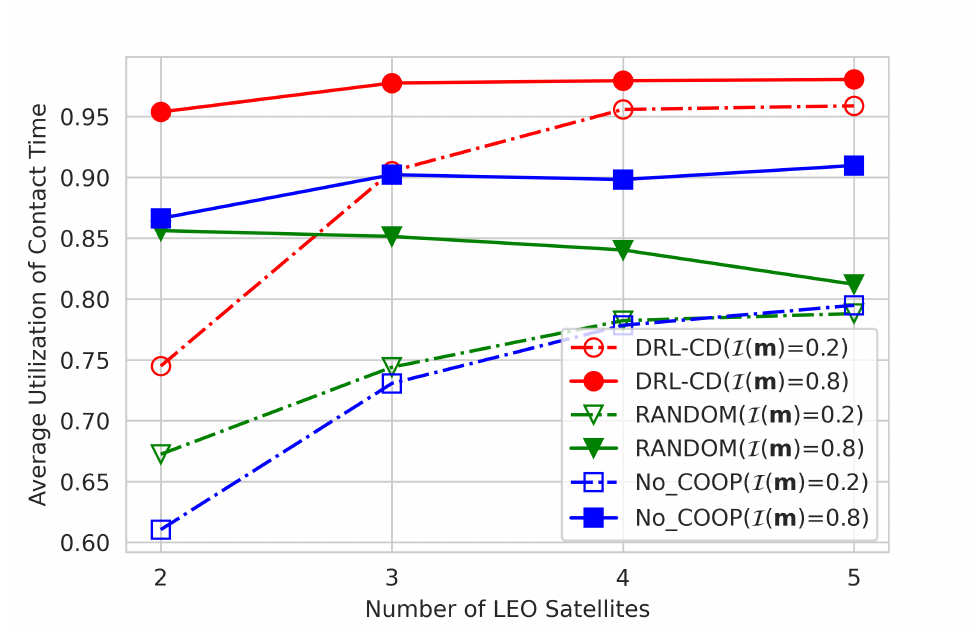
Figure 6. Number of satellites vs. average contact-time